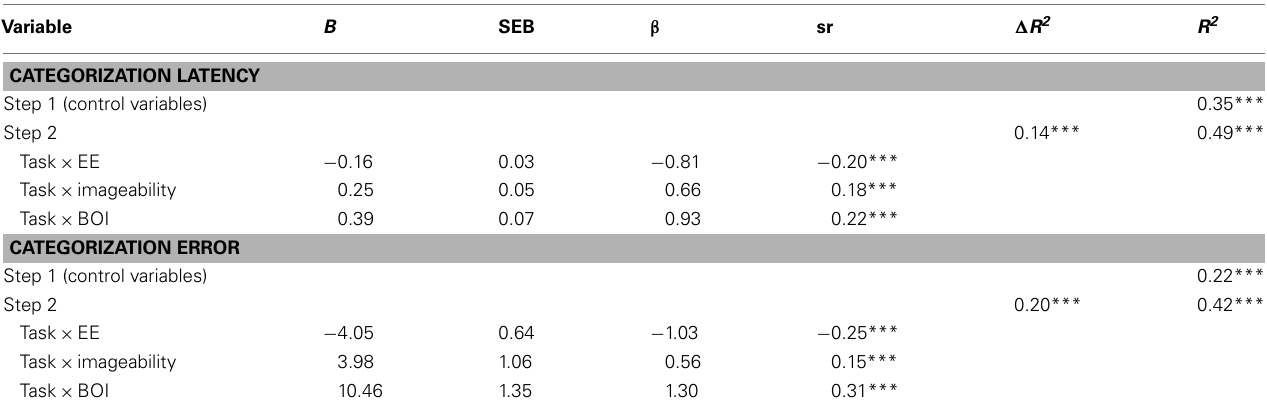
Table 4 | Results of interaction tests in the omnibus analyses.